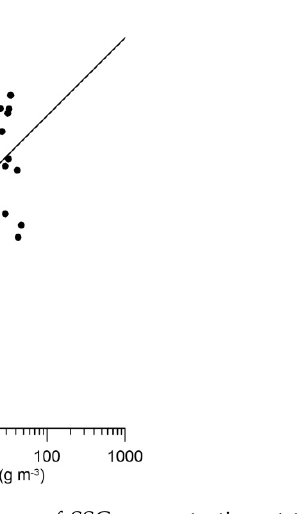
Figure 8. Comparison of calculations of SSC concentration at the surface with in-situ measurements [4].